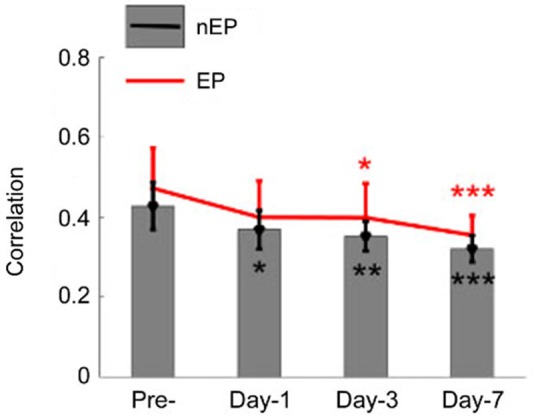
Cross-correlations between all channel pairs were averaged in all animals and shown for the EP and not-evoked signals as in Figure 6. A declining trend was observed in this group data after the injury (n = 9 rats, 20 trials per day). By the end of the survival period, the mean and std of correlations were reduced to 0.35 ± 0.04 (from pre-inj. of 0.47 ± 0.12) and 0.32 ± 0.03 (from pre-inj. of 0.43 ± 0.06) for EP and nEP, respectively. Wilcoxon-signed rank test, *P < 0.05, **P < 0.005, ***P < 0.001.